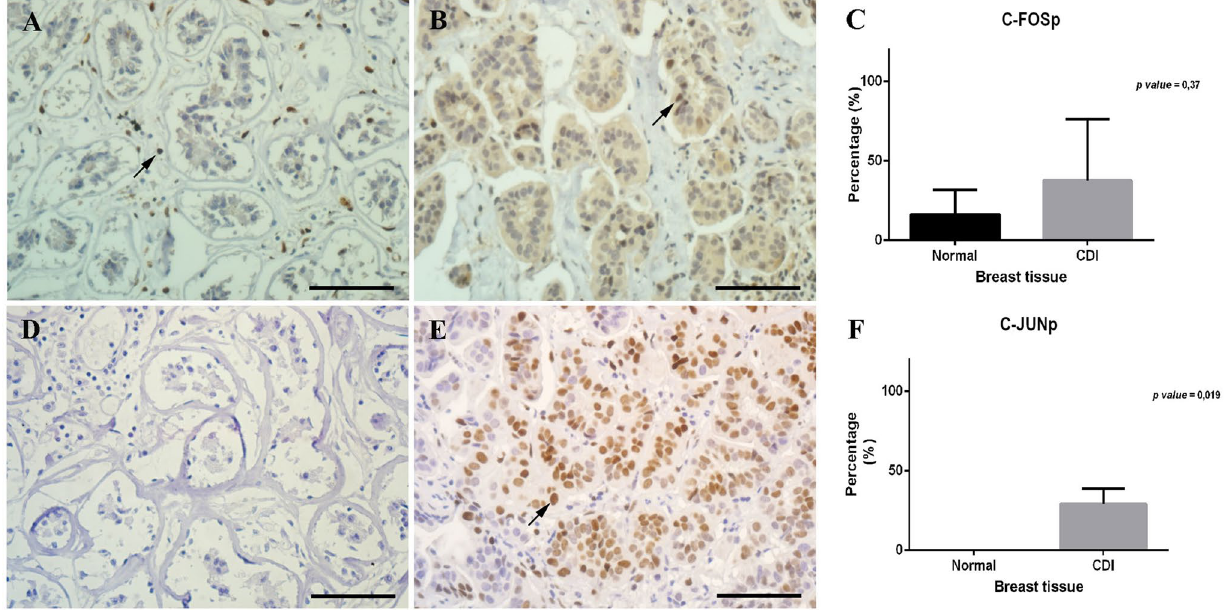
Figure 2. Immunohistochemistry assay confirming increased expression of C-JUN and CFOS in luminal A patients. ( A,B ) Using an antibody against phosphorylated C-FOS, we observed that C-FOS expression was slightly increased in luminal A patients ( B ) compared to mammoplasty tissue ( A ). ( C ) Graphical representation of C-FOS. Statistical analyses showed increased C-FOS expression in luminal A tissue compared to normal breast tissue (p-value = 0.37). ( D,E ) Using an antibody against phosphorylated C-JUN, we observed that C-JUN expression was slightly increased in the luminal A patients ( E ) compared to that in the mammoplasty tissue ( D ). ( F ) Graphical representation of C-JUN. Statistical analyses showed a significant increase in C-JUN expression in luminal A tissue compared to normal breast tissue (p-value = 0.019). Scale bar: 100 µm; magnification: × 400. The arrows indicate positive